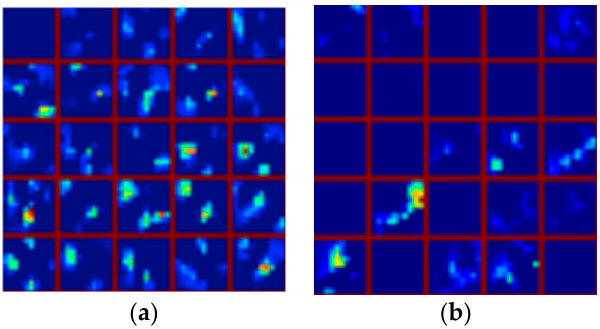
Figure 7. Visualization of feature maps output by the SE module ( a ) and the enhanced-SE module ( b